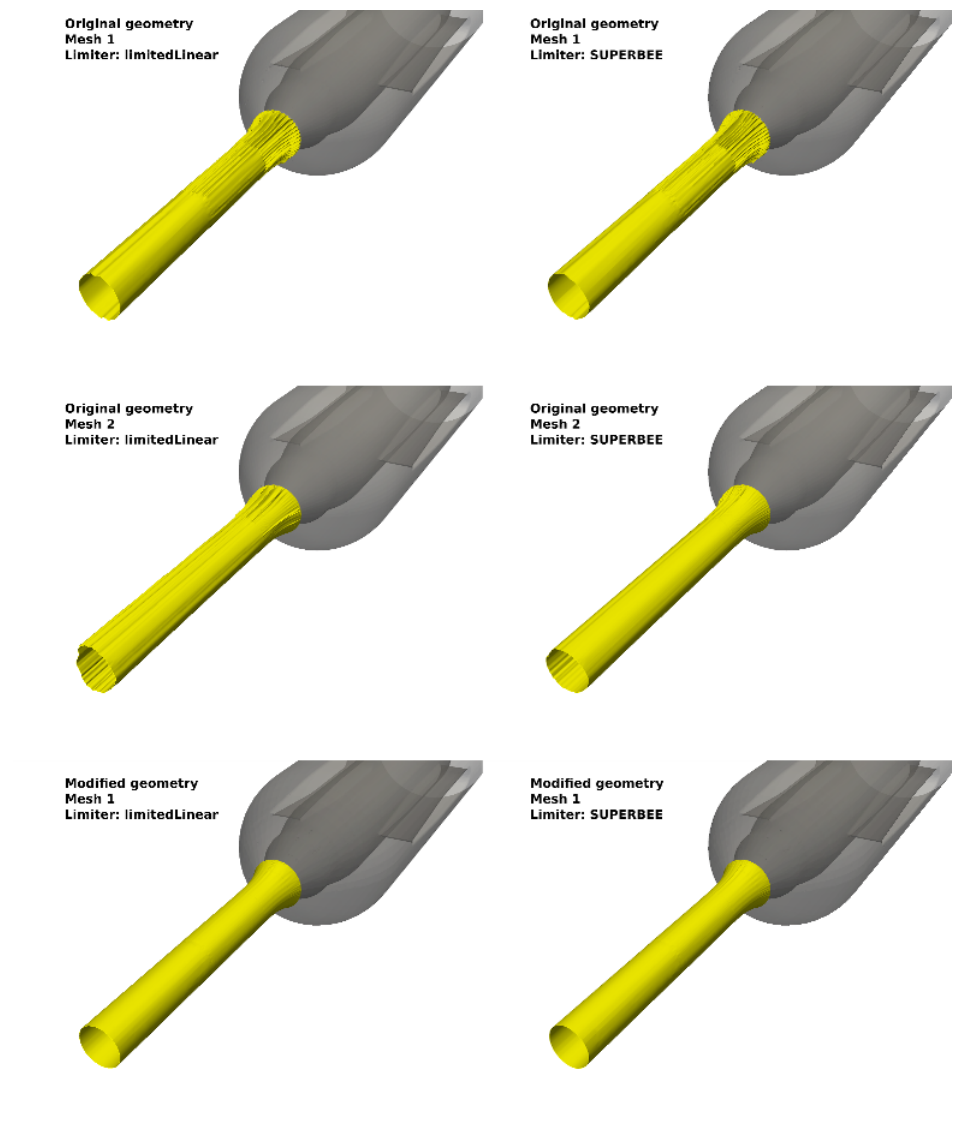
Figure 7. Iso-surface of the liquid volume fraction set to 0.5. Simulations for a needle stroke of 50%. Figure 10 displays, for a needle stroke of 50% and the simulations with the “SUPERBEE” limiter, the profiles of the liquid volume fraction and the dimensionless axial velocity along the green line shown in Figure 9. The dimensionless radial position r ∗ is computed as the ratio between the radial position and the nozzle diameter, whereas the dimensionless axial velocity C ∗ is computed as the ratio between the axial velocity and the theoretical a (cid:112) jet velocity defined by 2 gH . The simulation with the original geometry on mesh 2 is characterized by the narrowest jet width, the sharpest interface and the largest velocity deficit ( − 20%) in the wake of the needle. On mesh 1, the jet width is larger even if the jet interface is sharp and the velocity deficit is weaker, around − 10%. The simulation with the modified geometry shows a more diffuse interface since the liquid volume fraction varies from 1 to 0 for half of the jet radius and has a velocity deficit of the same order as the simulation with the original geometry on mesh